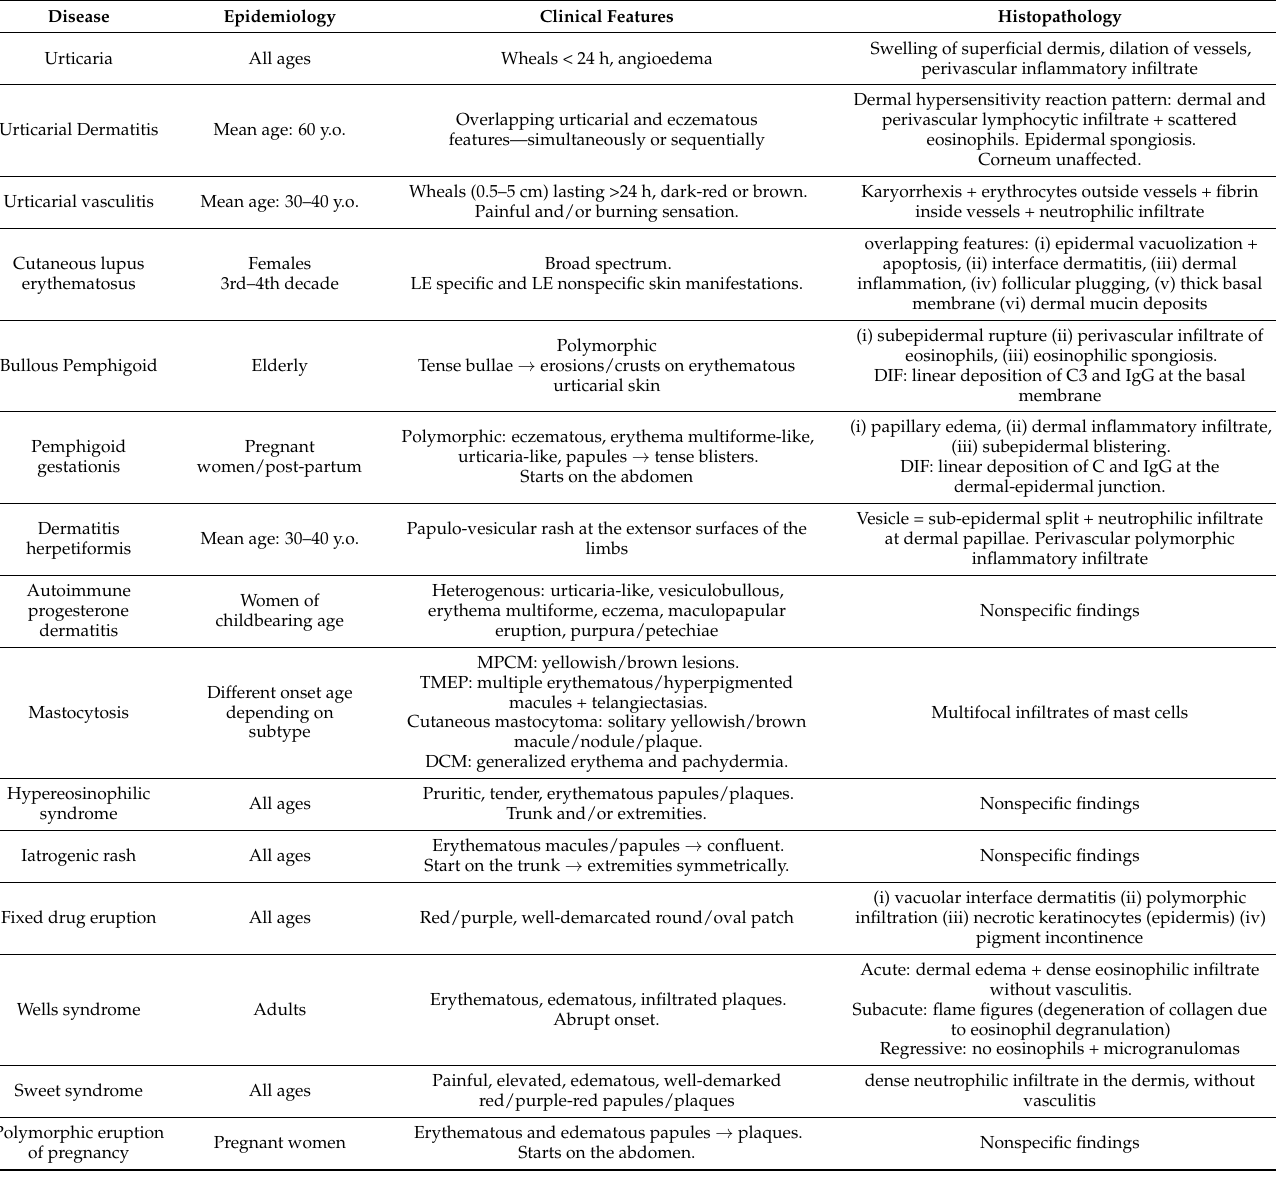
Table 1. Main differential diagnoses of